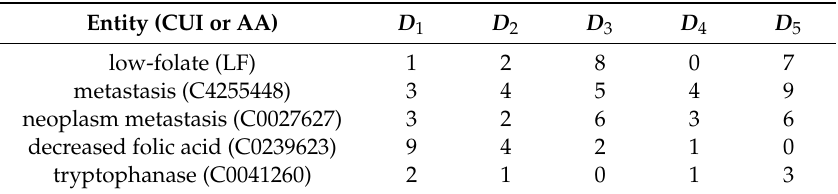
Table 2. Bag of words representation of